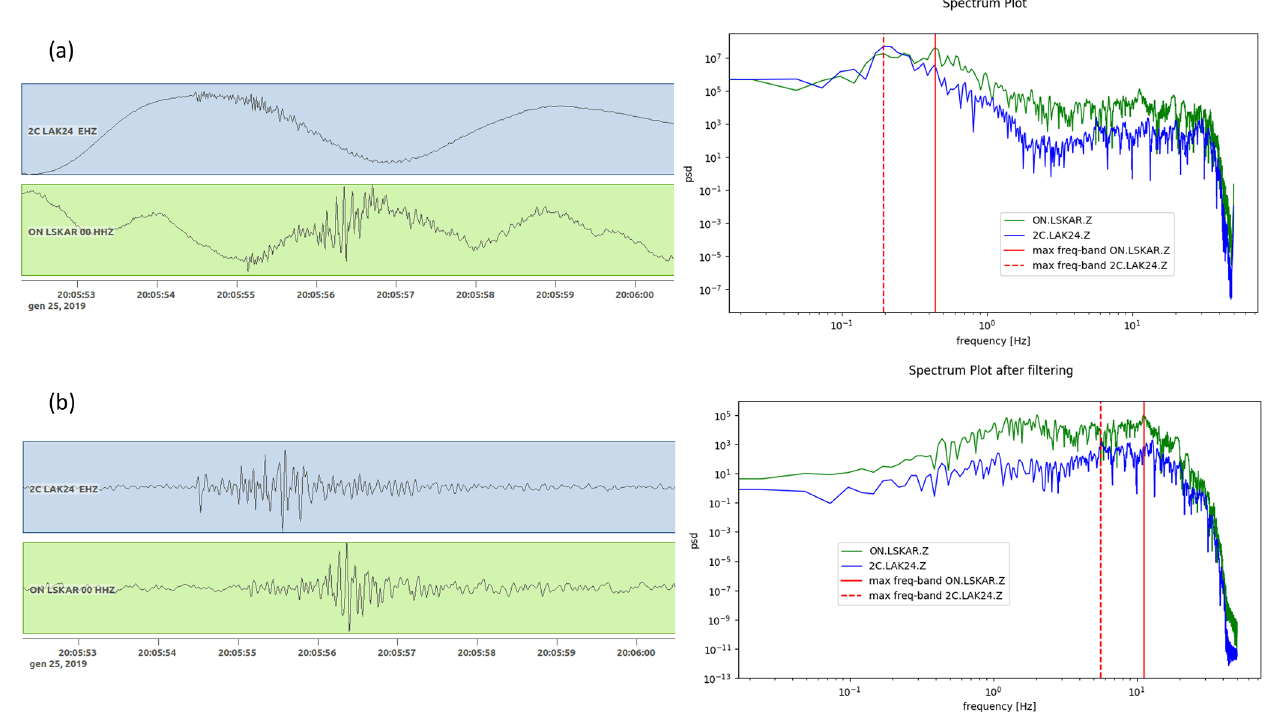
Figure 2. Recorded seismograms and power spectra of the event occurred on 25 January 2019 with magnitude 1.1 in raw (a) and after filtering between 2–15Hz (b) . Green box and lines are related to short period station (LSKAR), while blue ones refer to broad-band stations (LAK24, in green). Red solid and dashed lines indicate the most energetic frequency band recorded respectively by short period and broad-band